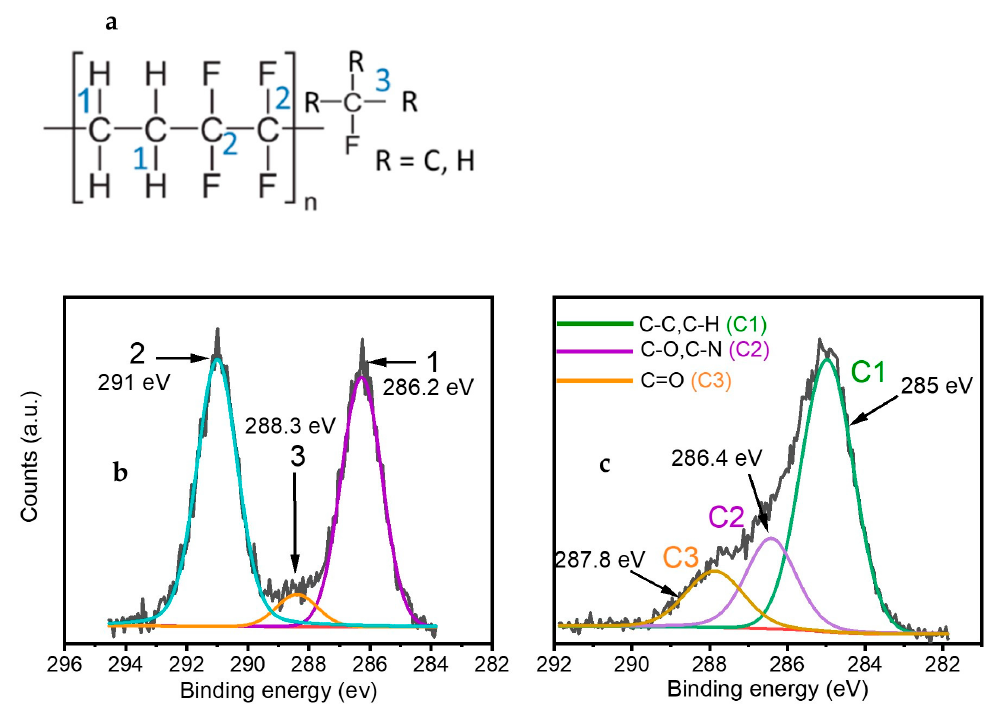
Figure 4. ( a ) Chemical formula of ETFE, and curve fitting of C 1s spectrum. ( b ) Untreated ETFE sample. ( c ) Typical plasma treated ETFE sample after a 180 s treatment.